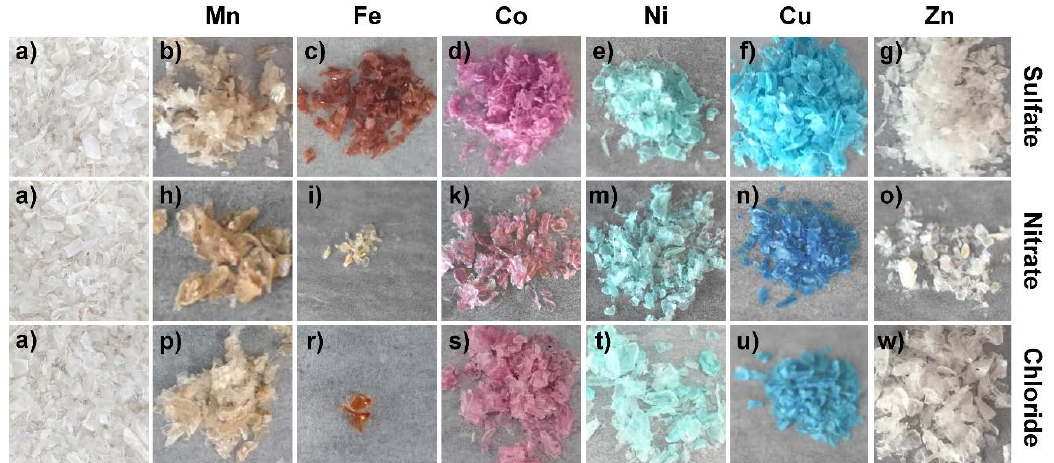
Figure 3. Images of: a ) pure chitosan flakes, b ) c 0 (MnSO 4 ) = 5900 mg·L −1 , h) c 0 (Mn(NO 3 ) 2 ) = 5800 mg·L −1